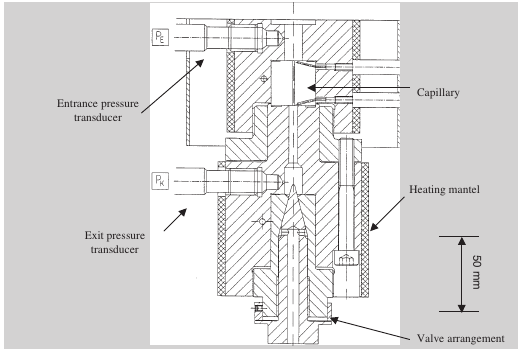
Figure 2: Schematic of the pressure tool consisting of a pressure chamber and a needle valve fitted beneath a standard capillary